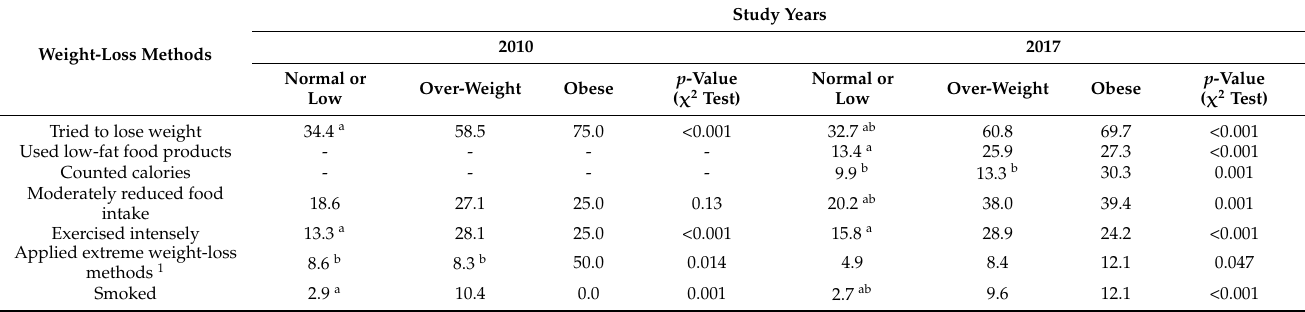
Table 4. Proportion (%) of students applying some weight-management practices by actual weight status.